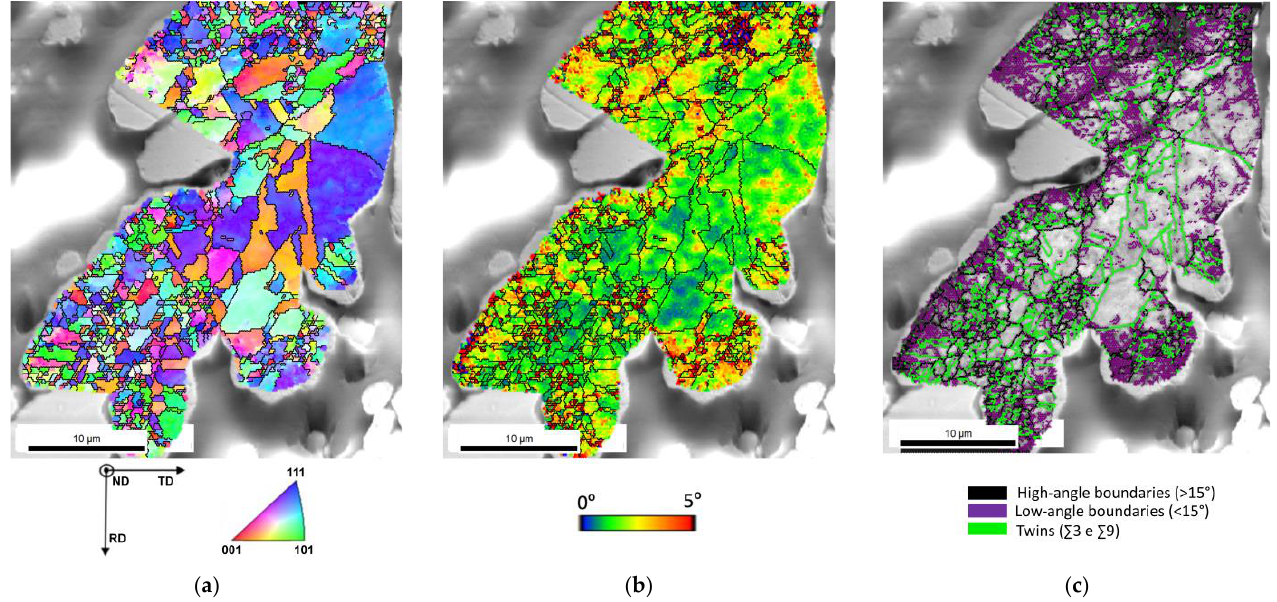
Figure 2. Cu powder particle as-received: ( a ) Inverse pole figure (IPF) map, ( b ) Kernel average misorientation (KAM) map overlapped with image quality (IQ) map, and ( c ) IQ map with delineated high- and low-angle boundaries as well as twins.